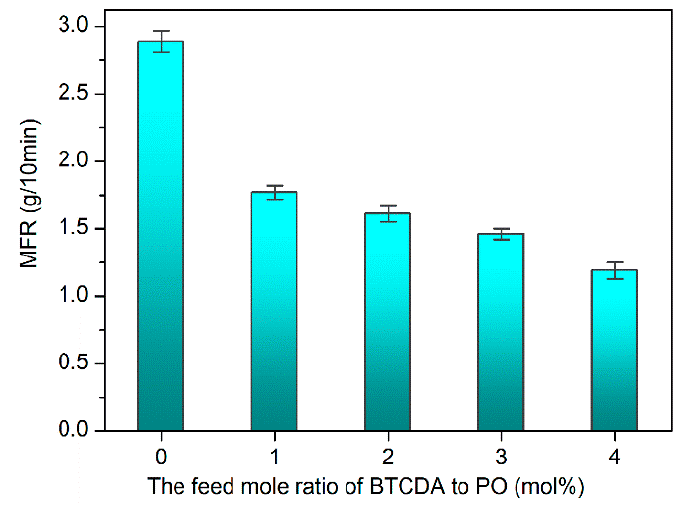
Figure 3. The melt flow rate (MFR) of PPC and PPC with networks.